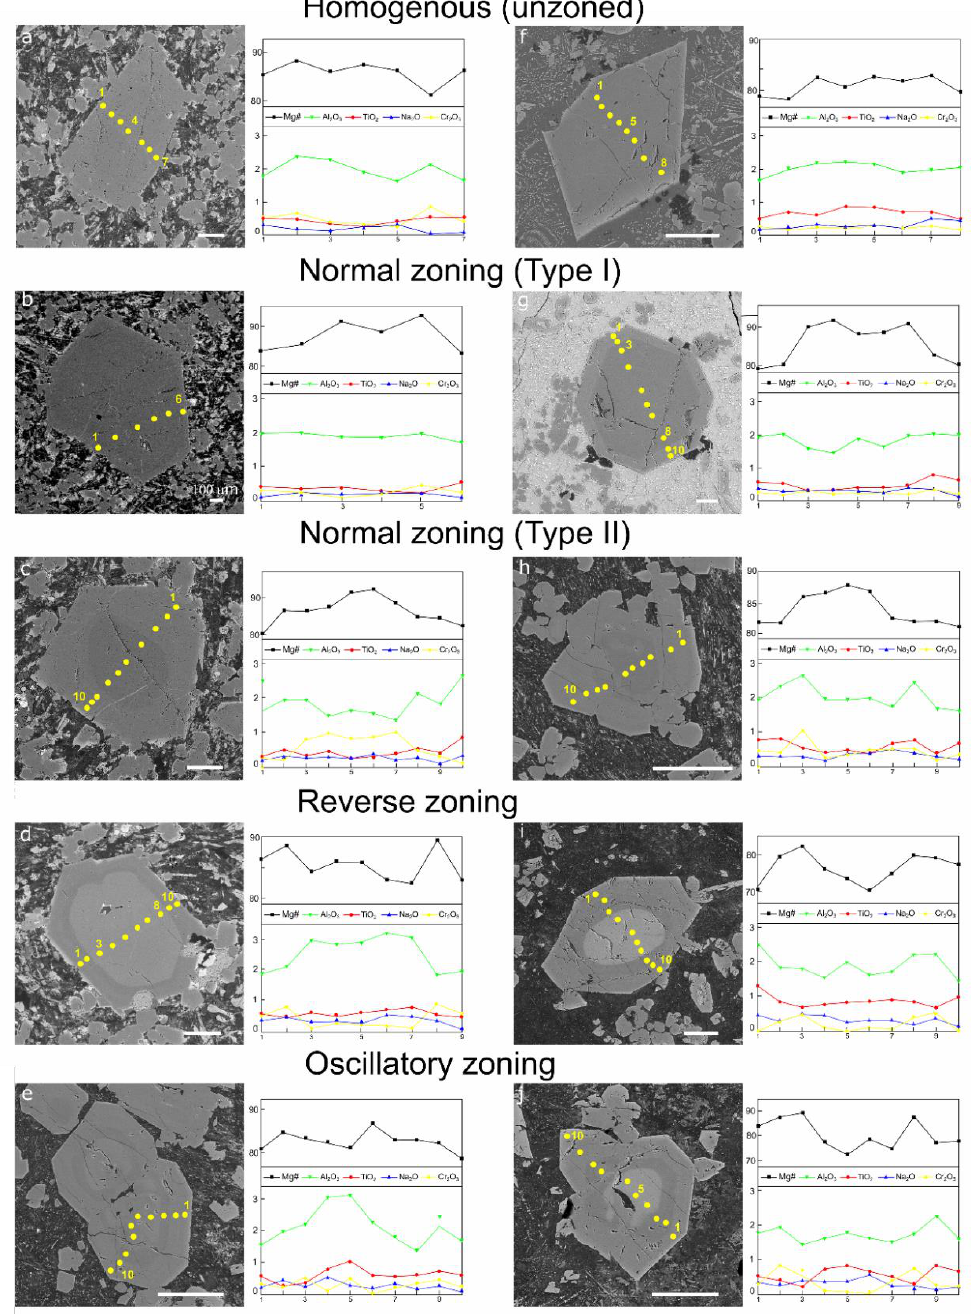
Figure 3. Representative BSE images and analytical points with major element compositions for clinopyroxene phenocrysts from the massive ( a – d ) and variolitic ( e – j ) lavas with various zoning patterns. Scale bar corresponds to 100 µ m. The yellow dots mark the single point EDS analysis.